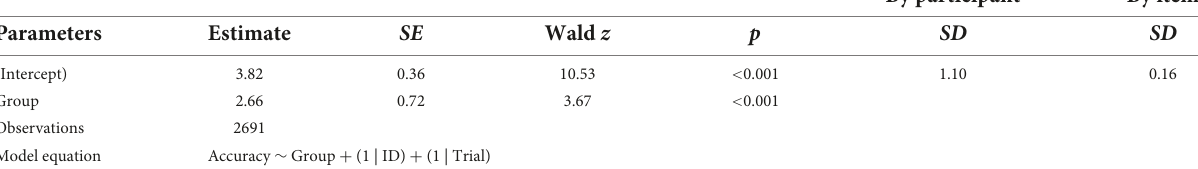
TABLE 6 Regression coefficients of group on case marking